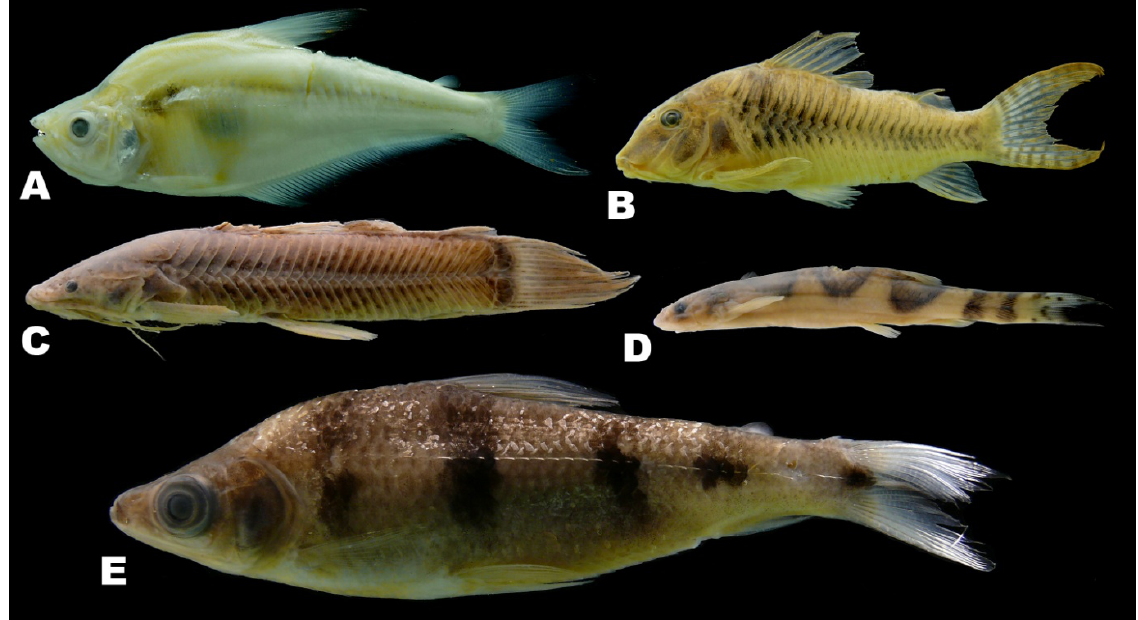
Figure 5. Examples of species collected only in the Alto Yuruá. (A) Roeboides affinis (70 mm). (B) Corydoras stenocephalus (54 mm). (C) Callichthys callichthys (59 mm).